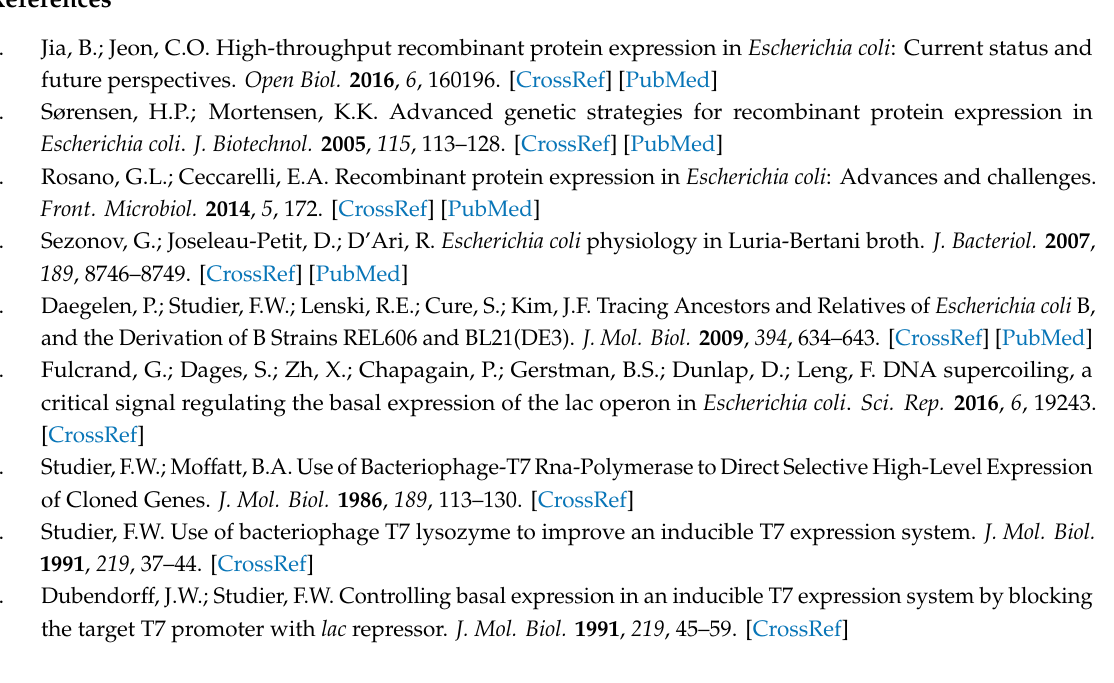
Table S1: Physiological parameters of cultivations at q s,lac,max at di ff erent q s,glu